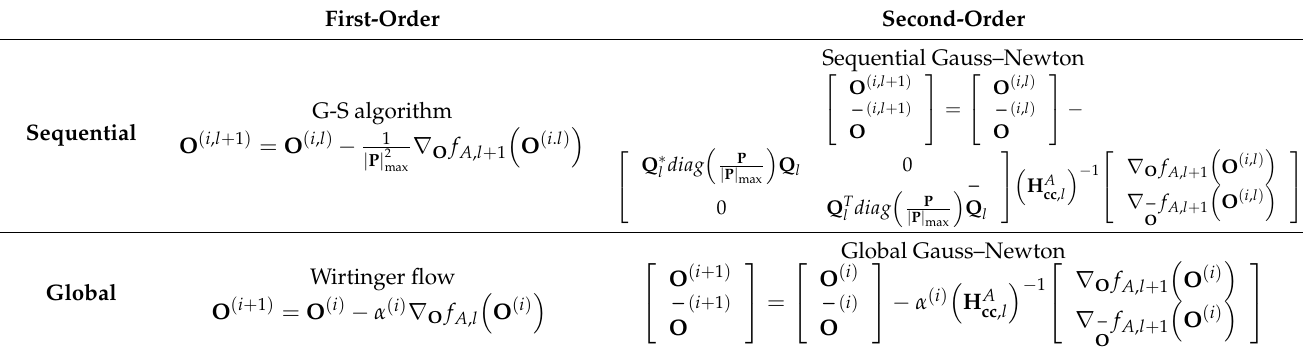
Table 1. Classification of typical reconstruction algorithms for FPM (Adapted from Ref.